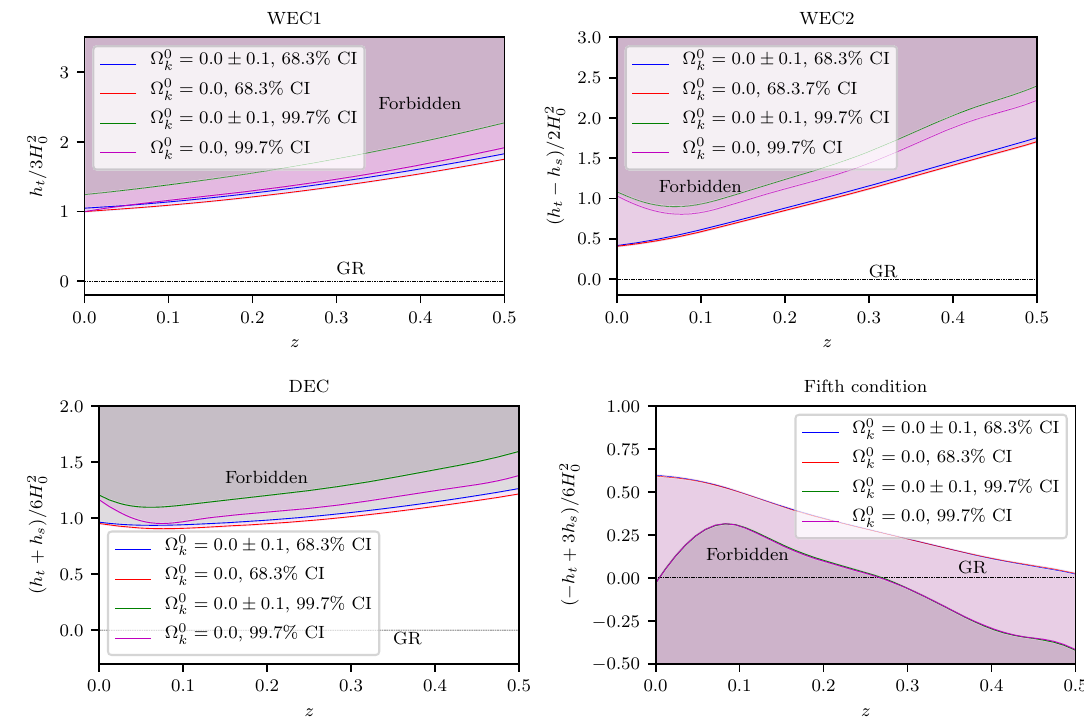
Fig. 4 Similar to Fig. 3. The results are presented in the redshift interval [ 0 , 0 . 5 ] , where the reconstruction of q ( z ) is better constrained, i.e., presents smaller variances than for higher redshifts